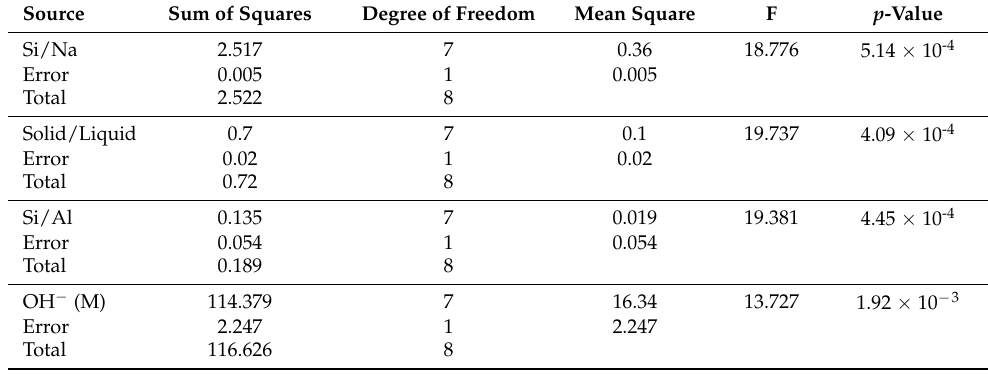
Table 3. Results of one-way ANOVA for compressive strength and factor parameter of the SCSGPs.